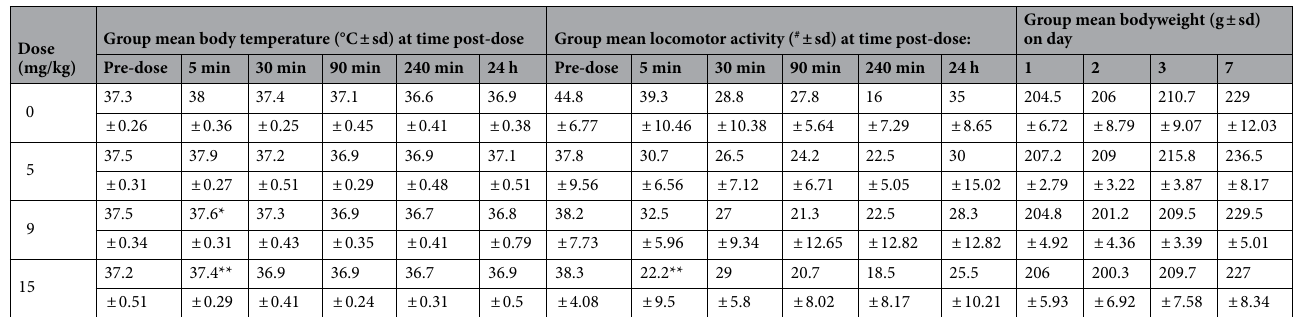
Table 4. Effects of intravenous bolus injection of SET-M33 at 0 (vehicle = 0.9% saline solution), 5, 9 and 15 mg/kg on body temperature, locomotor activity and body weight in male rats (group mean values ± standard deviation). Statistical significance compared with vehicle: * p < 0.05, ** p < 0.01. The results of each treated group were compared with those of the vehicle-treated control group by analysis of variance and Williams test. # Number of times the rats entered a new square in the